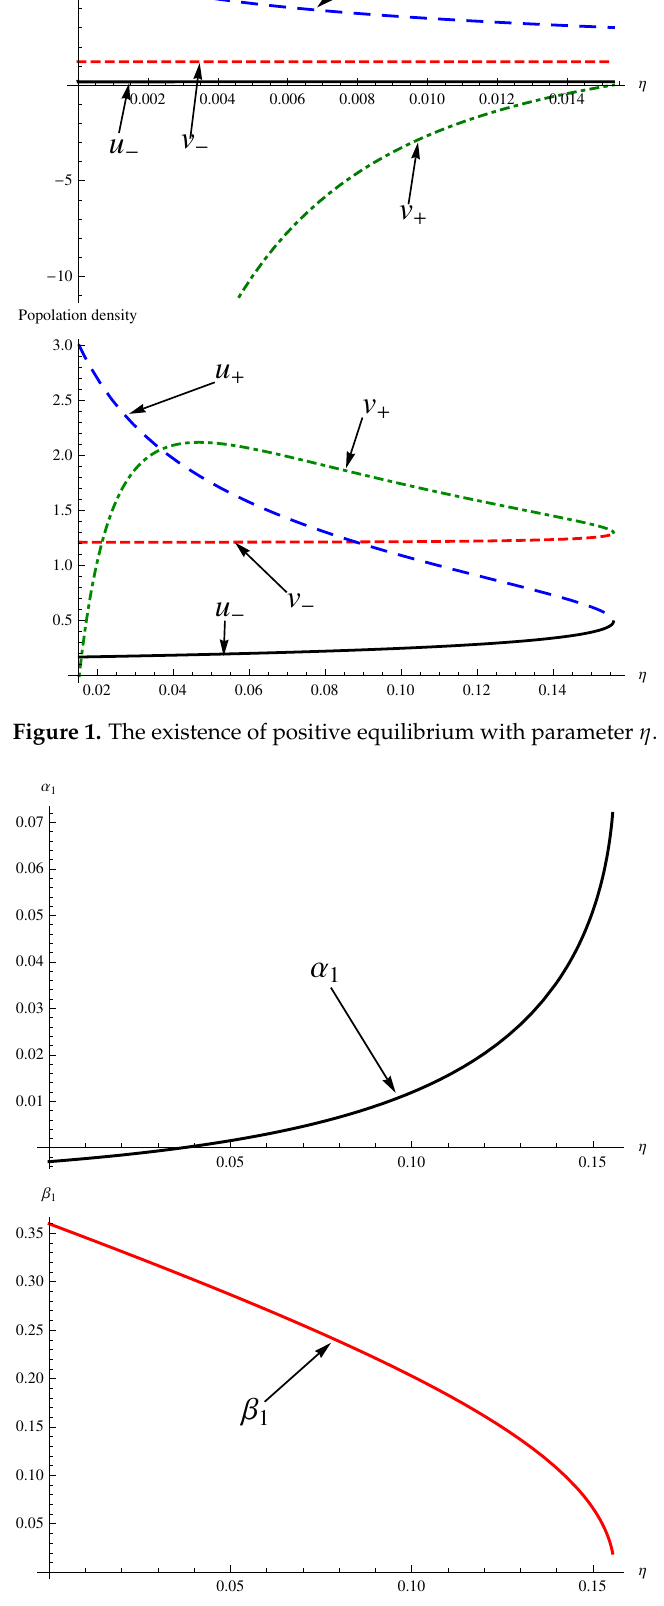
Figure 2. α 1 and β 1 with parameter η at ( u − , v − )